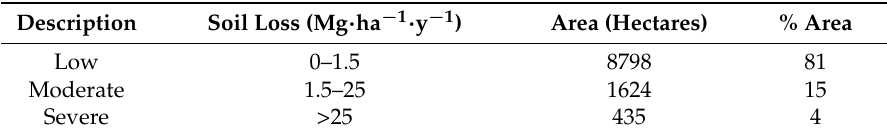
Table 3. Soil loss distribution in the Palar sub-watershed.